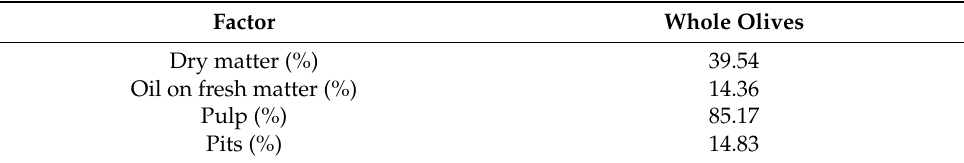
Table 1. Main characteristics of the whole olives